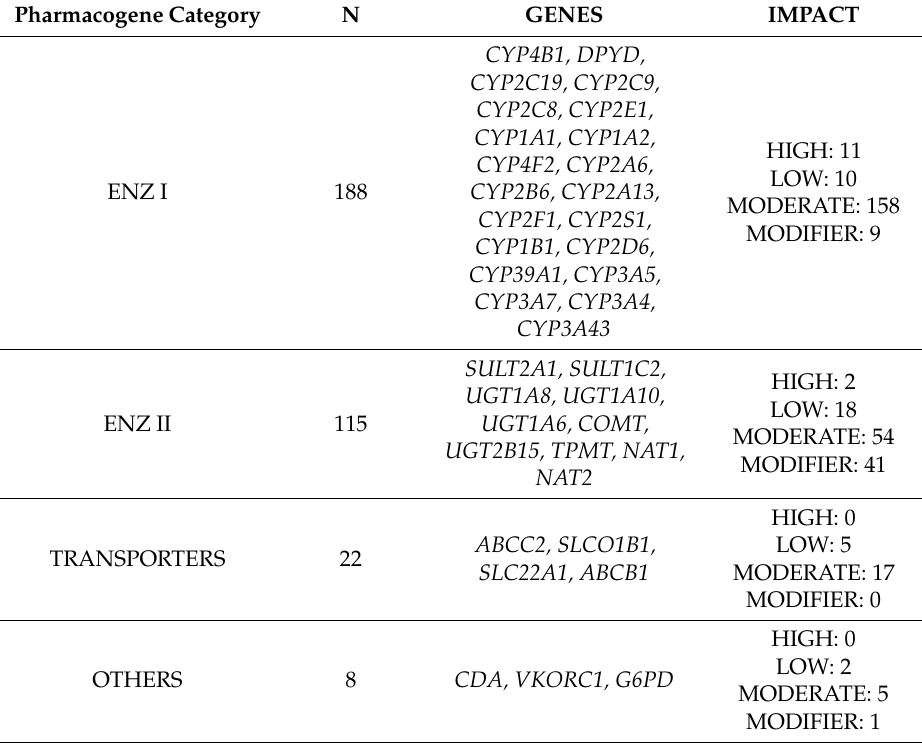
Table 2. Count of PGx variants per pharmacogene family and VEP impact within the shared PharmGKB variants between Lakiotaki et al. (2017) [16] and DiscovEHR cohort. Abbreviations: ENZ I, Phase I metabolizing enzymes; ENZ II, Phase II metabolizing